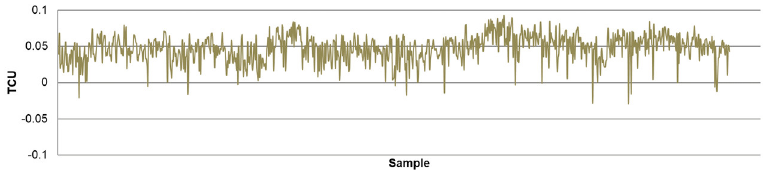
Figure A25. Prediction error of PMM model testing dataset for TCU output variable. Table A2. Regression statistics parameters of PMM model testing dataset.